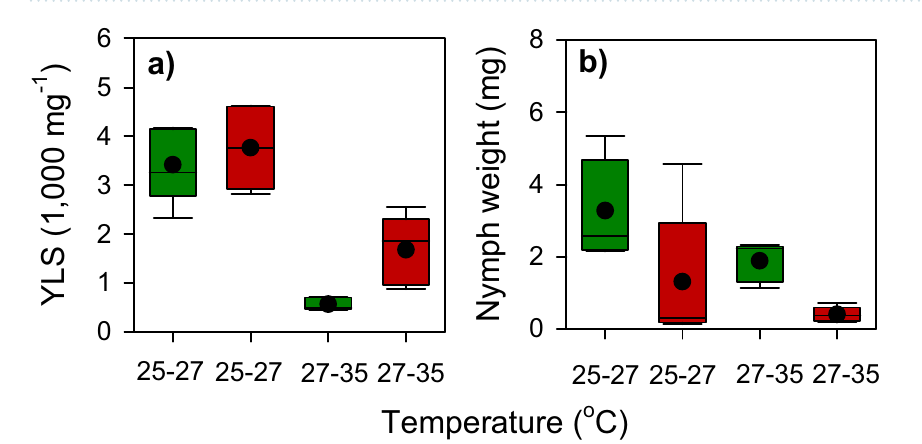
Figure 5. ( a ) Densities of yeast-like symbionts (YLS) in planthoppers reared on IR22 (green squares) and IR62 (red squares). Nymphs were maintained in an insectary at 27 °C for 7 days after exposure to 25 °C or 35 °C during 3 days. The corresponding wet weights of the nymphs are indicated in b . Black circles indicate sample means (N =